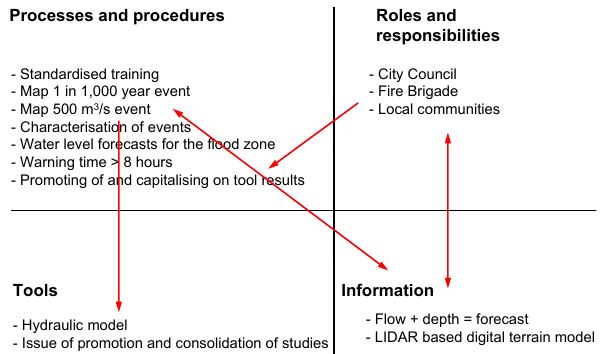
Fig. 8. Cross-table for “flood hazard map” for Tarascon, developed during the workshop.